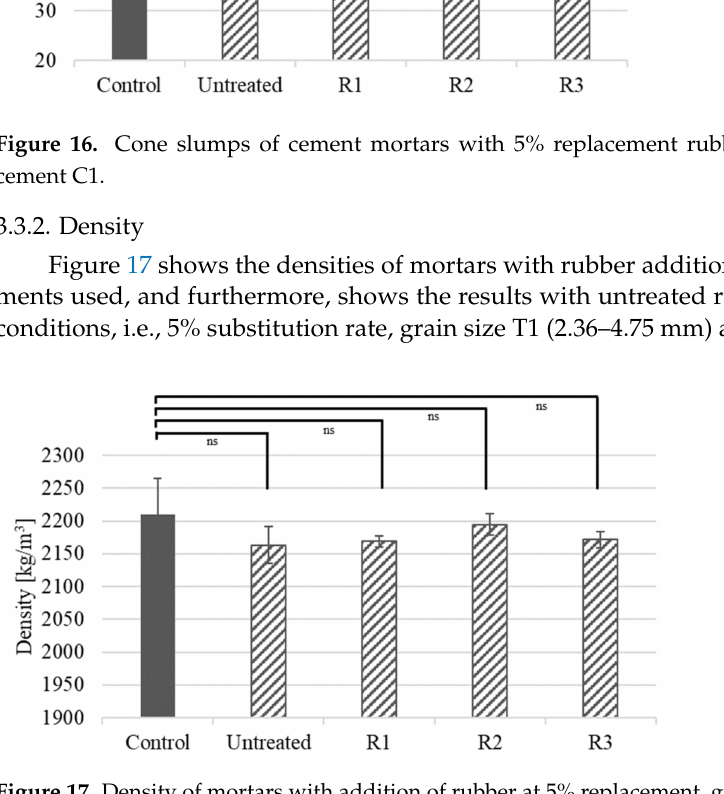
Figure 17. Density of mortars with addition of rubber at 5% replacement, grain size T1, using cement C1. ns =